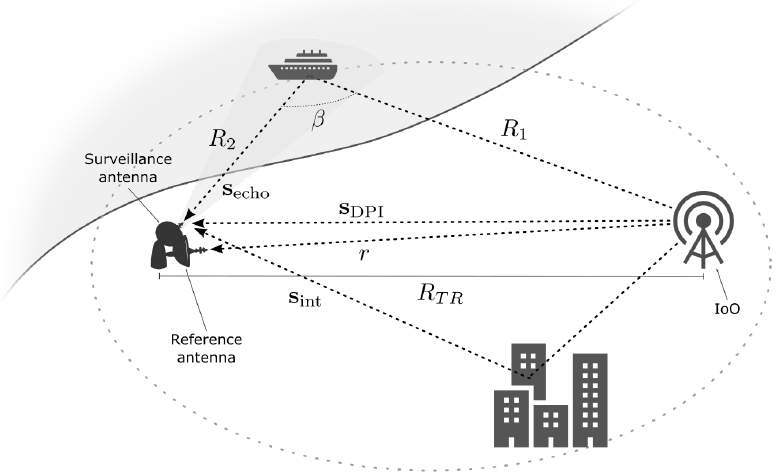
Figure 1. Basic bistatic passive radar